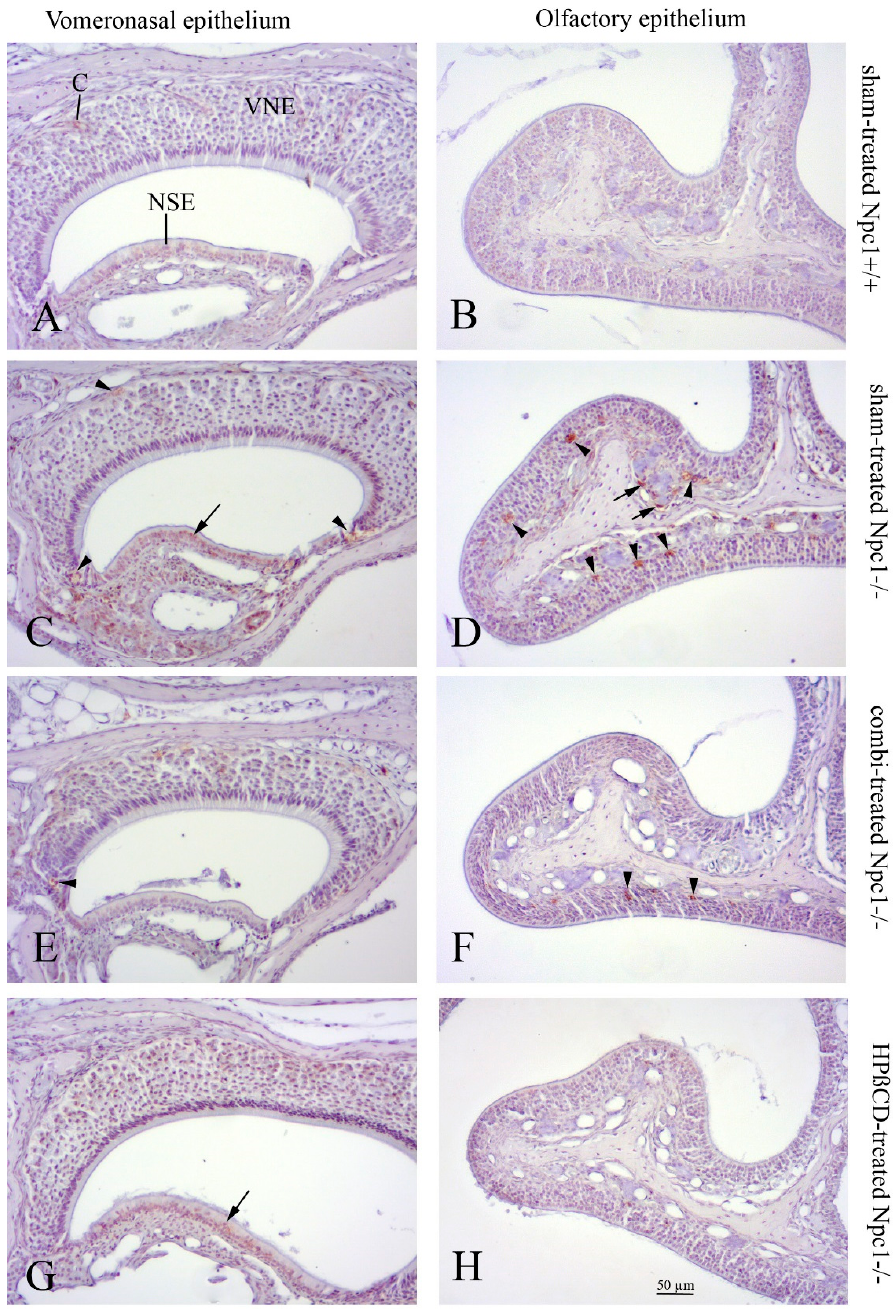
Figure 7. Cathepsin D (Cath D)-immunohistochemical comparison of lysosomal activity between vomeronasal (left column) and olfactory mucosa (second endoturbinate; right column) of the correspondent animals. ( A ) Apart from a slight positive reaction of non-sensory epithelium (NSE) and intraepithelial capillaries (c), sham-treated Npc1 +/+ mice show almost no Cath D(+) cells; ( B ) almost no reaction in the OE of sham-treated Npc1 − / − animals; ( C ) sham-treated Npc1 − / − : Cath D(+) reaction in proliferative marginal zones (arrowheads), NSE (arrow) and underlying connective tissue, but barely within the VNE. ( D ) In contrast, the same animal presents numerous Cath D(+) lysosomes in the OE, probably of macrophages (arrowheads); also within olfactory ensheathing cells around olfactory nerve fiber bundles in the lamina propria (arrows). Combination-treated Npc1 − / − mice ( E,F ) and HP β CD-treated Npc1 − / − ( G,H ) animals presented a somewhat changed nuclear morphology (flattened nuclei), but markedly reduced Cath D-reactive deposits (arrow in G ; arrowheads in F ) indicating that treatment did not completely prevent pathologic alterations.